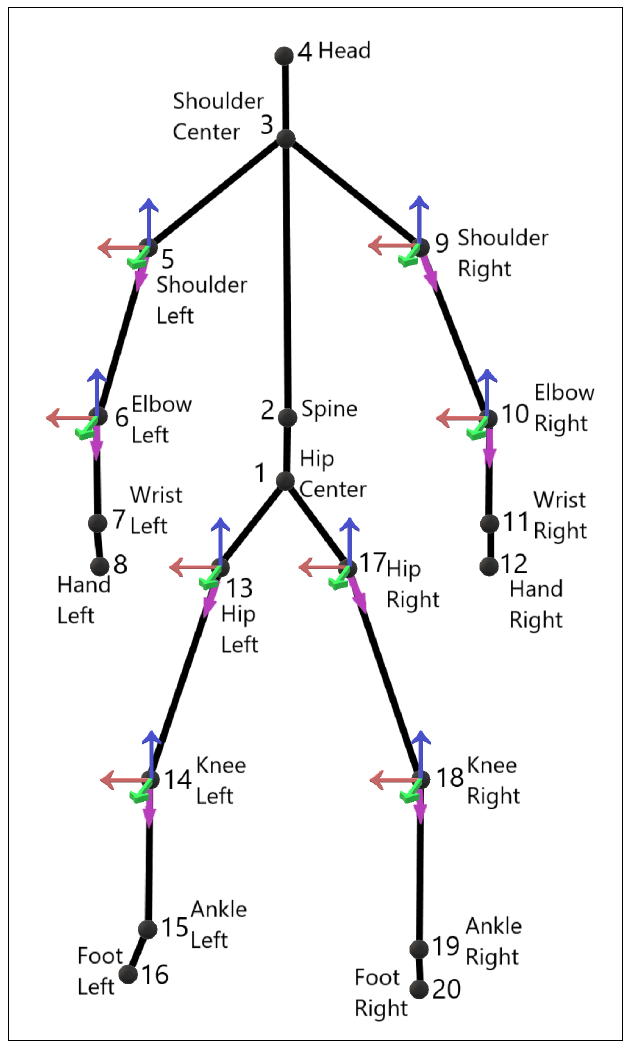
Figure 8. Origin of the rotation of all used articulations in red, green and blue. Purple represents the current position of the articulation.